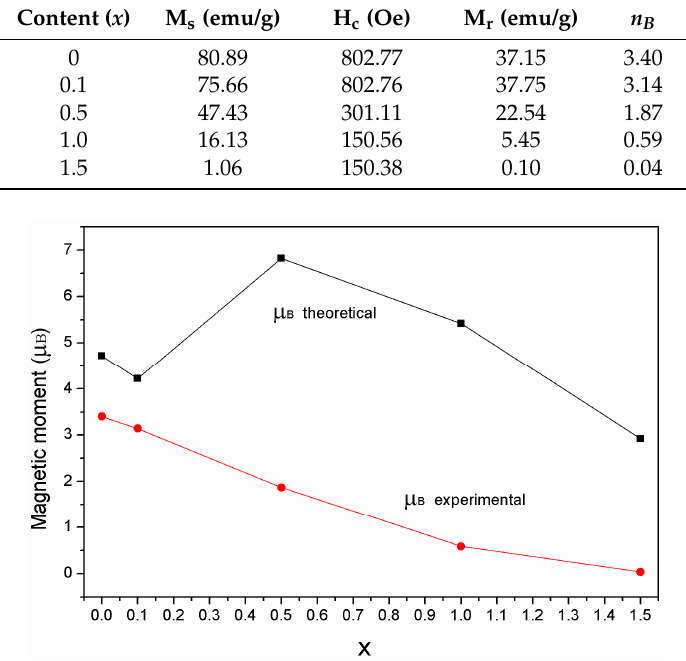
Figure 7. The hysteresis loops of CoAl x Fe 2 − x O 4 samples calcined at 1000 °C. Magnetic parameters of CoAl x Fe 2 − x O 4 calcinated at 1000 ◦ C obtained from hysteresis measurements. Content ( x )